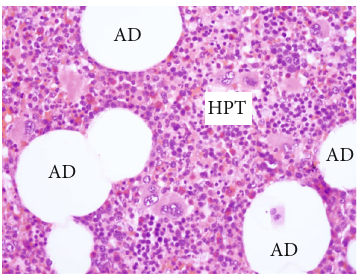
Figure 3: Microscopic appearance of myelolipoma with normal adipocytes (AD) and normal trilineage hematopoietic tissue (HPT) (hematoxylin-eosin staining, original magni fi cation